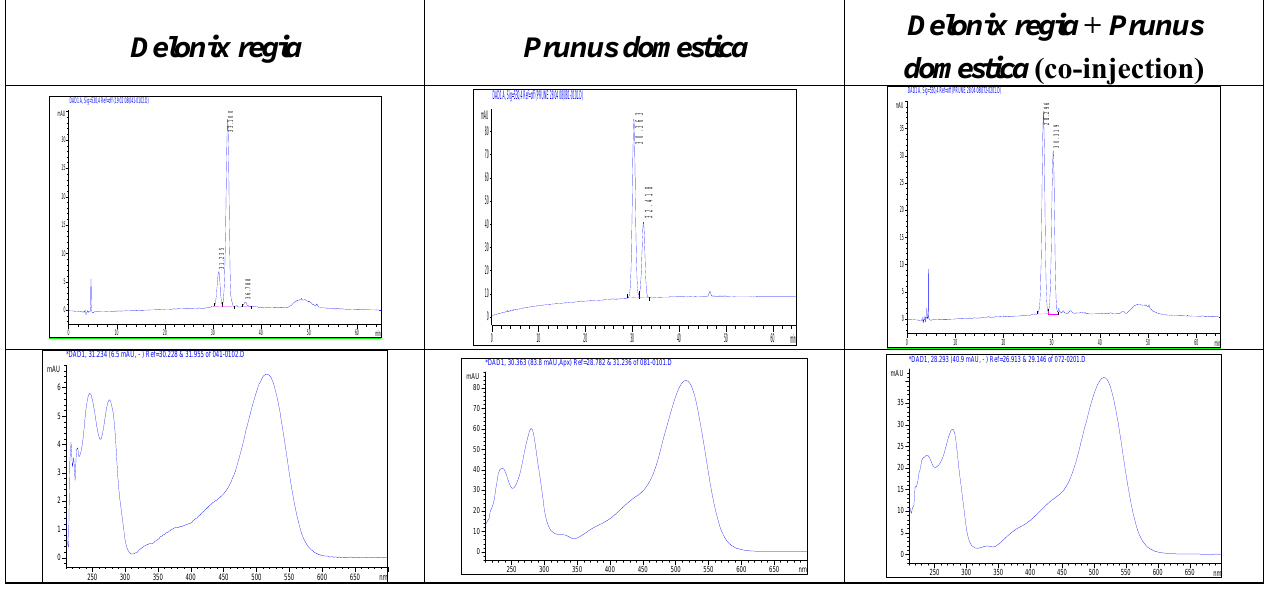
Figure 2. HPCL-DAD ( λ 530nm) analysis of anthocyanins of acidified water-extracts of dry Delonix regia flowers and fresh Prunus domestica fruits and corresponding UV-vis spectra of compound 2 . Delonix regia Prunus domestica